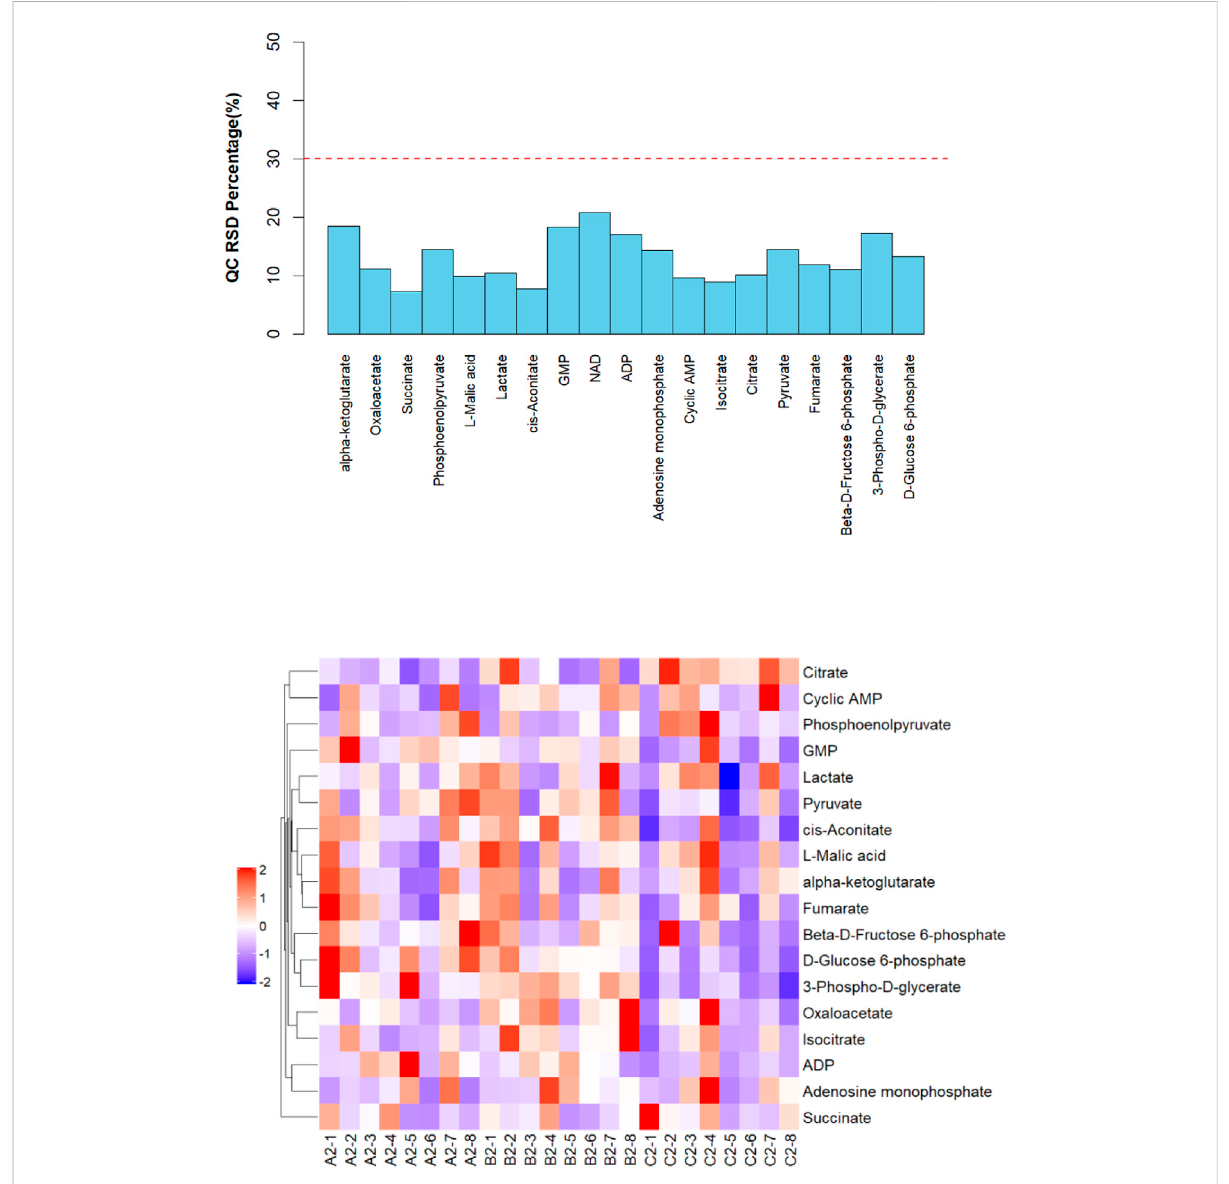
FIGURE 6 RSD distribution of QC samples, and urine metabolite hierarchy clustering plots